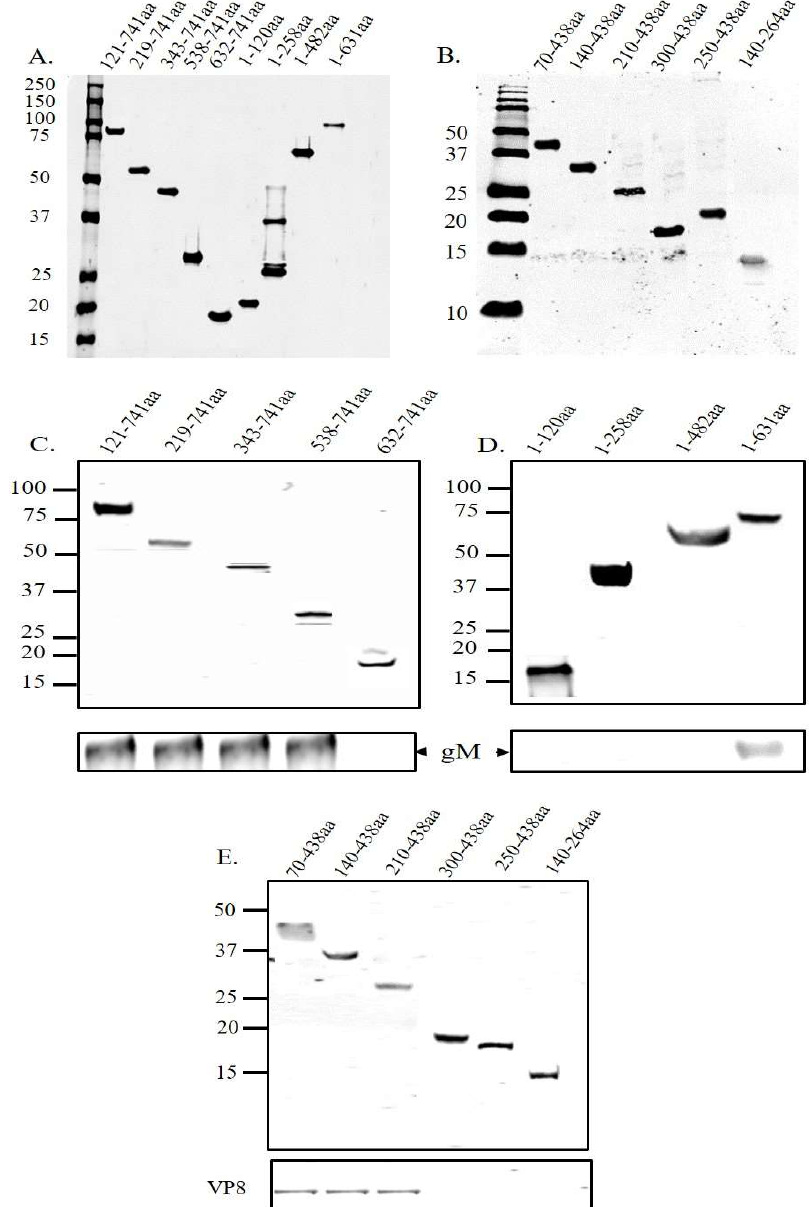
Figure 7. Identification of the interacting domains of VP8 and gM. EBTr cells were co-transfected with FLAG-tagged truncated VP8 versions and pgM-HA or with HA-tagged truncated gM versions and pFLAG-VP8, and the lysates were either directly analyzed by SDS-PAGE ( A , B ) or incubated with anti-FLAG ( C , D ) or anti-HA ( E ) beads. After elution by SDS loading dye, the samples were subjected to SDS-polyacrylamide gel electrophoresis on a 4–15% gel and transferred to 0.45 µm nylon membranes. ( A ) Expression of truncated versions of VP8 protein. ( B ) Expression of truncated versions of gM protein. ( C ) Immunoprecipitation of full-length gM-HA by N-terminal VP8 deletions shows an interaction of gM-HA with all VP8 versions except the deletion lacking amino acids 1–631. ( D ) Immunoprecipitation of full-length gM-HA by C-terminal VP8 deletions shows an interaction of gM-HA with VP8 consisting of amino acids 1-631, but not with the other VP8 versions. ( E ) Immunoprecipitation of full- length VP8-FLAG by truncated gM-HA proteins shows an interaction of VP8-FLAG in the presence of the amino acids 70–438, 140–438, and 210–438 of gM-HA. Molecular weight markers × 10 − 3 are shown in the left